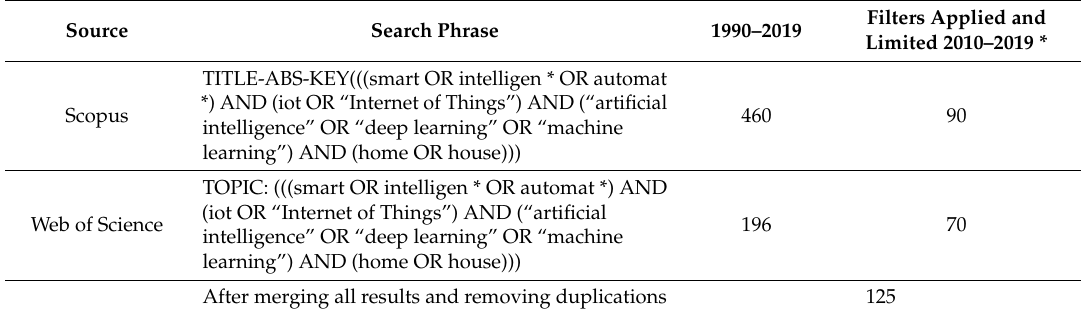
Figure 1. The flowchart of the search process, the exclusion and inclusion criteria, and the number of records found in each step. Table 3. Search phrases and the number of documents found to develop the AISH dataset for bibliographic analysis.